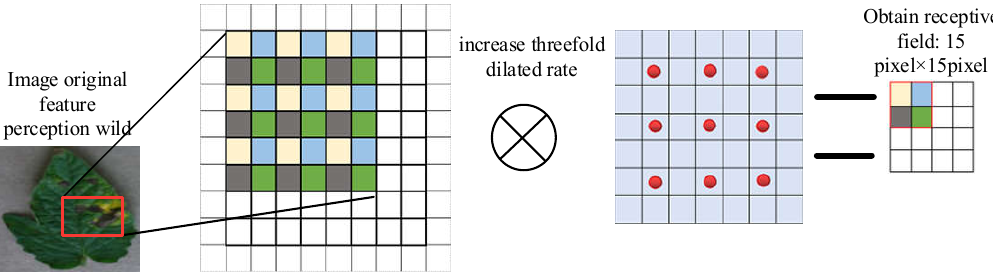
Figure 3. The extraction process of dilated convolution 3 × 3 convolution kernel feature.